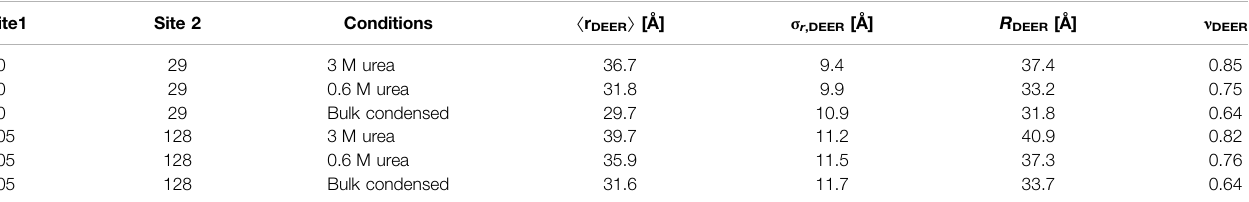
ν fi edfortheSAW- ν DEER andscalingexponent DEER arespeci